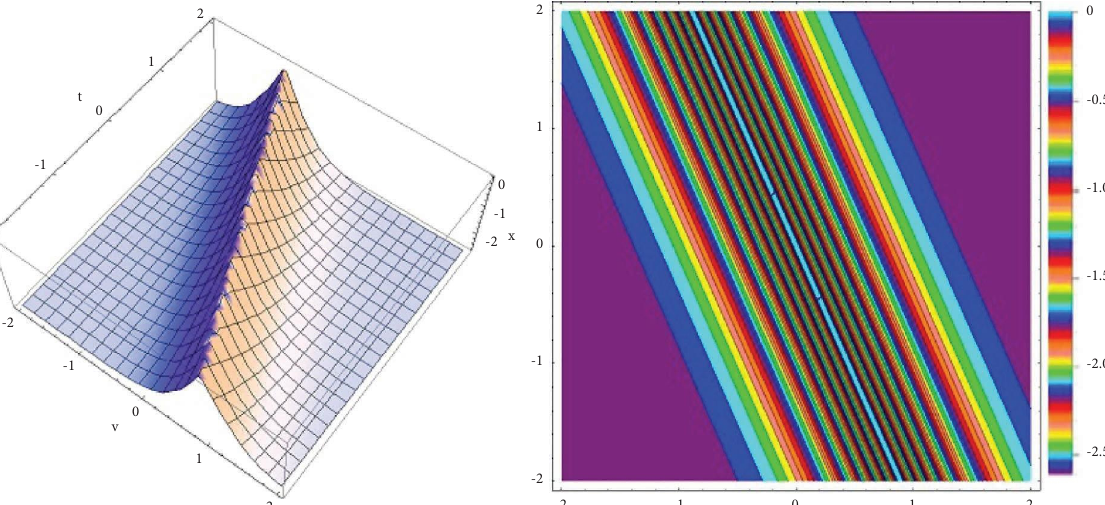
Figure 6: Sharp bell shape soliton drawn from (13) for ω � 2 . 25.